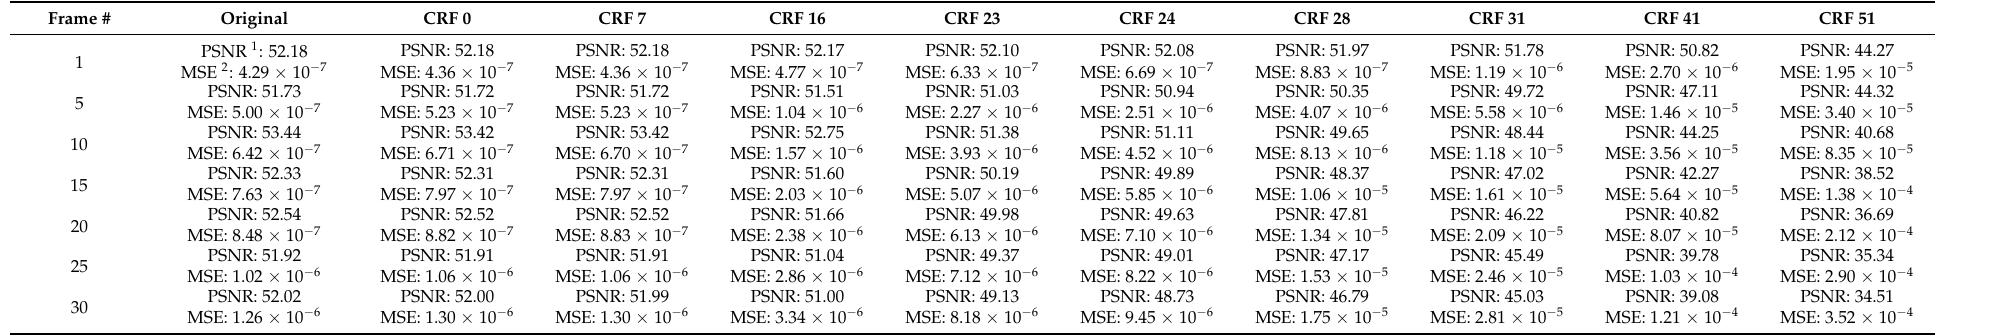
Table 7. Encoder operation results for a 1920 × 1080 video fragment compressed with a 128 × 128 encoder trained for CRF = 24 compared to the original image and to a video fragment compressed by HEVC compression for MSE and PSNR changes in